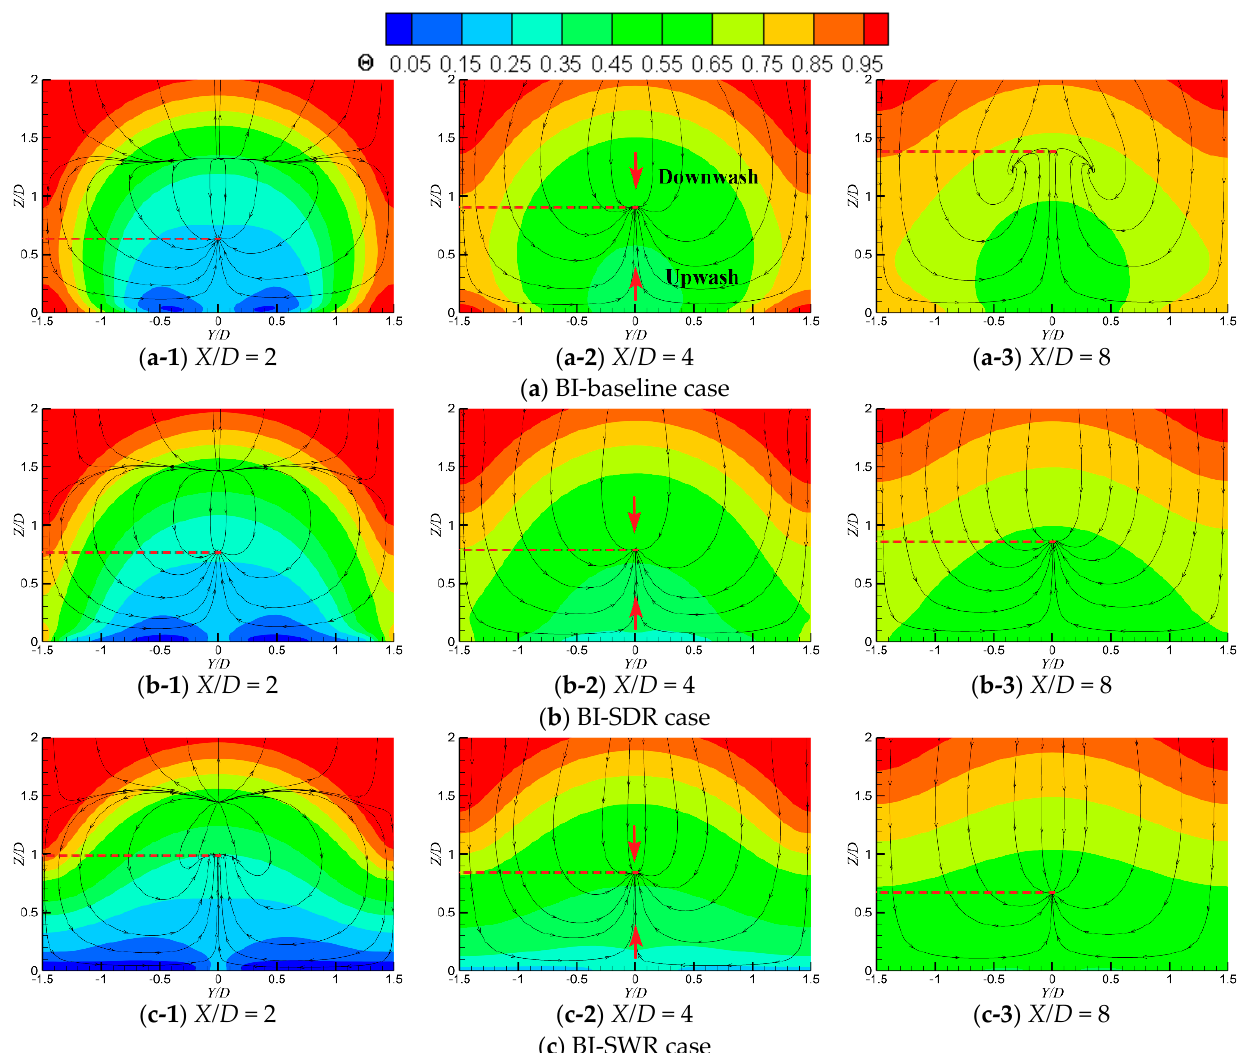
Figure 11. Local streamlines and dimensionless temperature contours at X/D = 2, 4, 6 in BI cases.